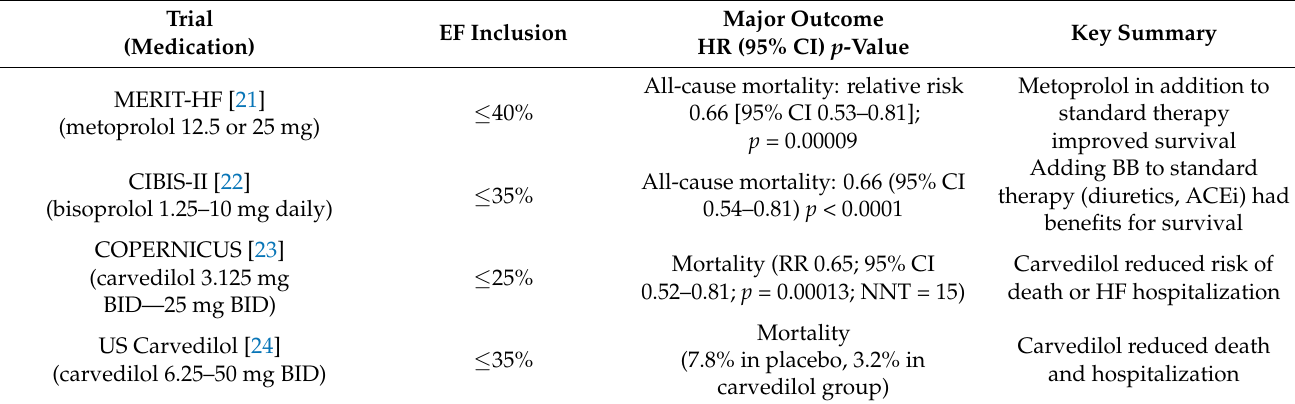
Table 4. Beta blocker heart failure trials.